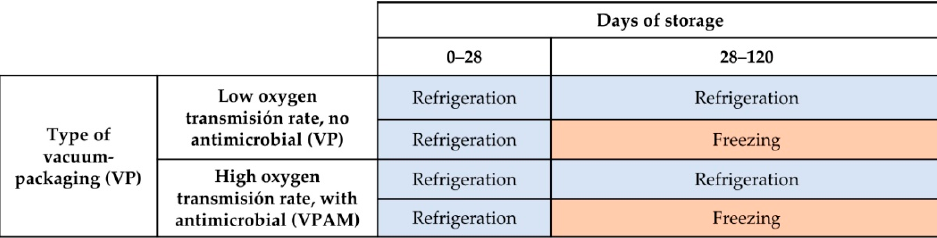
Figure 1. Treatments and experimental